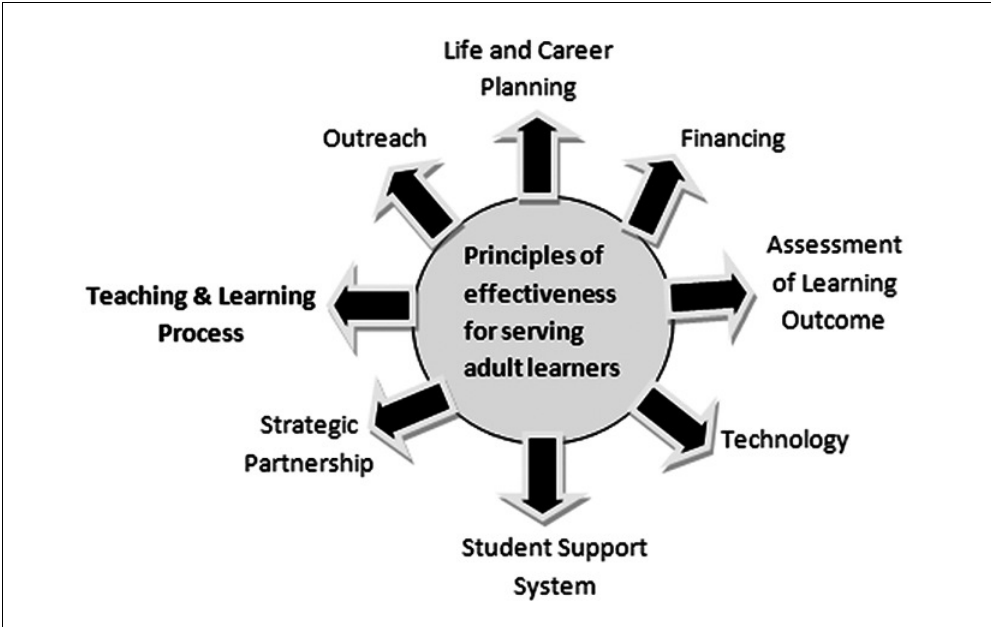
Figure 1 Principles of effectiveness for serving adult